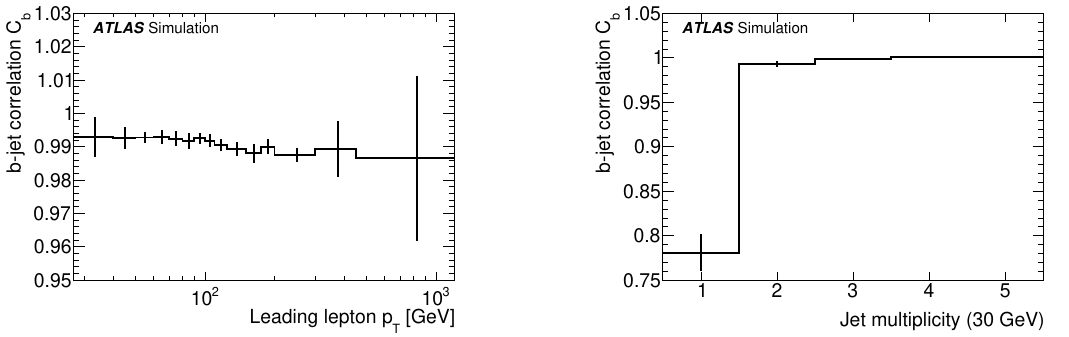
Figure 13 . Distribution of the b -jet correlation factor C b as a function of the p lead. lep. the jet multiplicity (right), as determined from the nominal t ¯ t simulation. The uncertainties shown include MC statistical and systematic